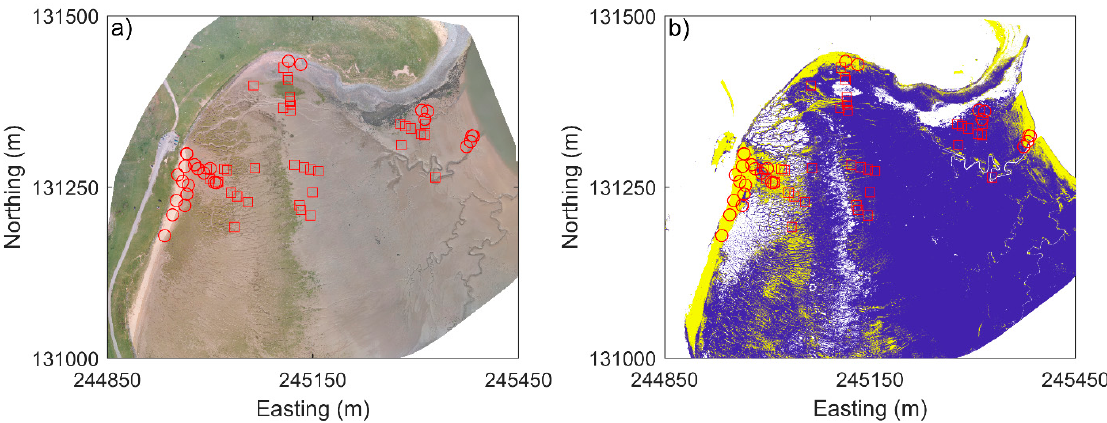
Figure 12. The Appledore orthomosaic ( a ) and sediment classification ( b ) with visual sediment classification marked in red (circles sand; squares mud). Yellow indicates sand classification and blue mud.